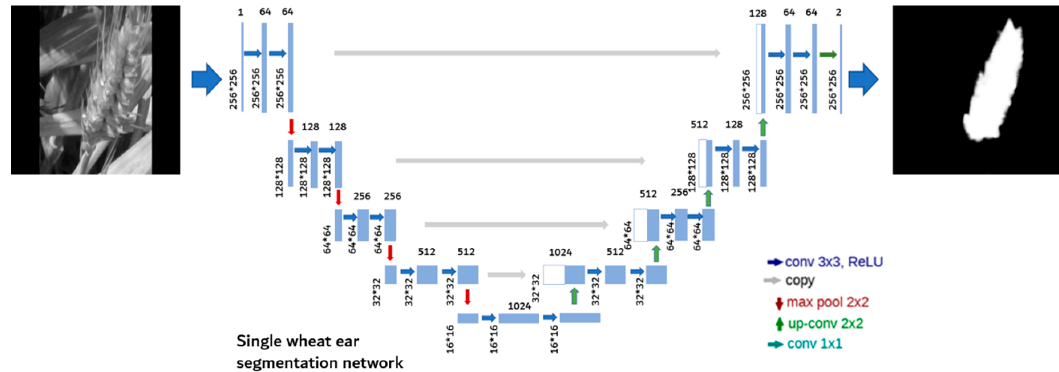
Figure 4. Single wheat ear segmentation network. The input is a filled grayscale image, the output is a grayscale image of single wheat ear. The left side of the network consists of eight 3 × 3 convolution layers and four 2 × 2 maximum pooling layers. The right side of the network contains eight 3 × 3 convolution layers, one 1 × 1 convolution layer, and four 2 × 2 deconvolution layers.